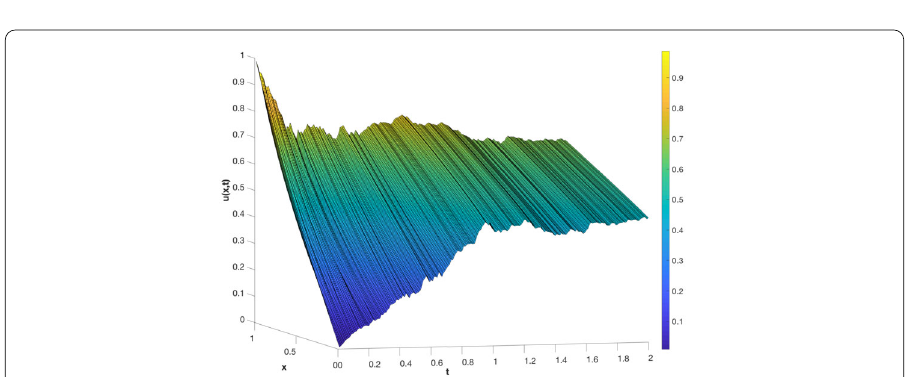
Figure 2 Sample path of the Lighthill–Whitham–Richards model with initial condition 1 – x perturbed by the term –(1 – 2 u ) · u x ◦ d W t . Here we took a sample path without doubling points due to